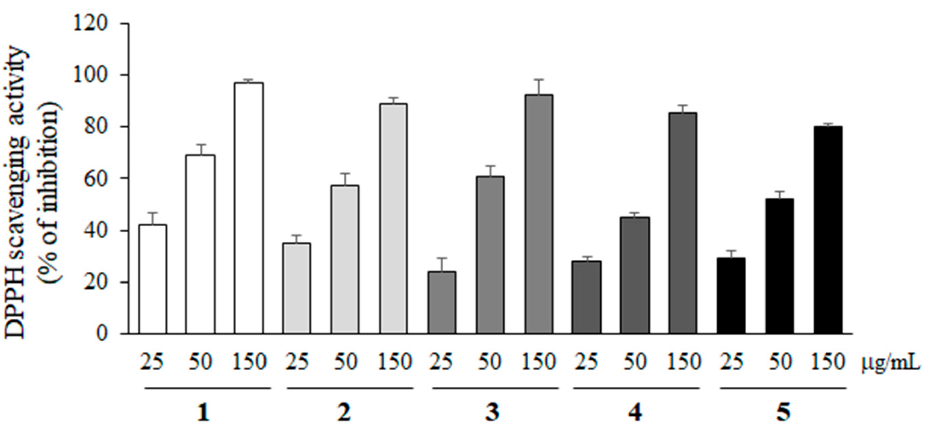
Figure 3. DPPH radical scavenging activity of compounds 1 – 5 . The antioxidant effects of compounds 1 – 5 were measured at 25, 50, and 150 µ g/mL with DPPH free radicals. All data represent the mean ± SD of three different experiments.